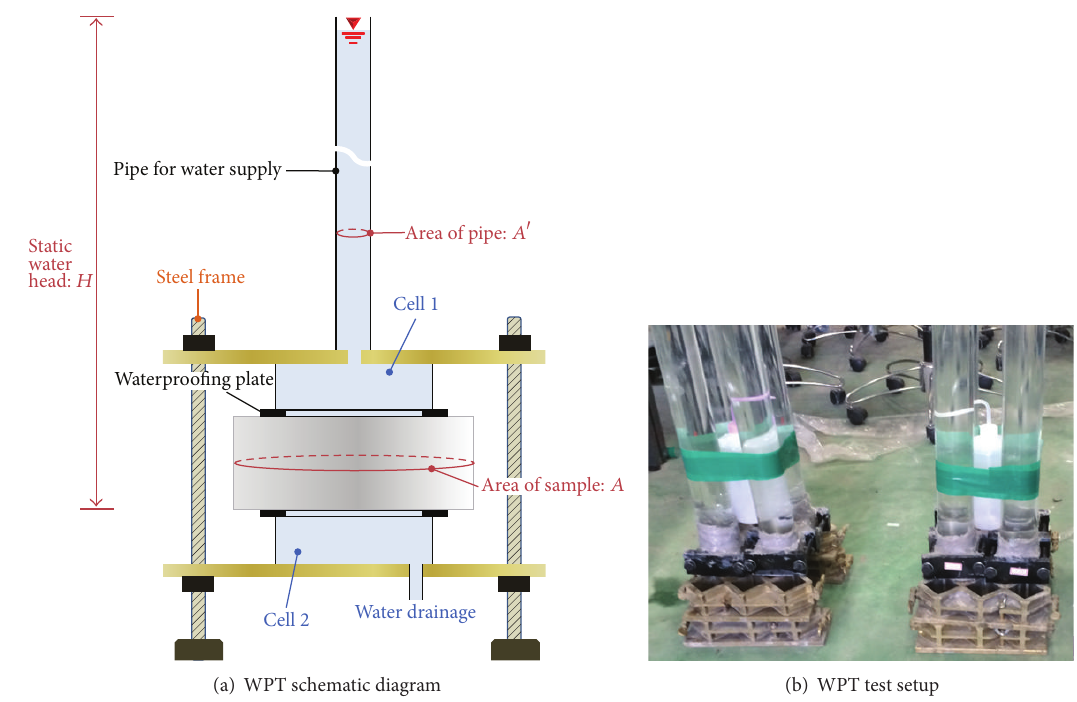
Figure 6: WPT schematic diagram and test setup.